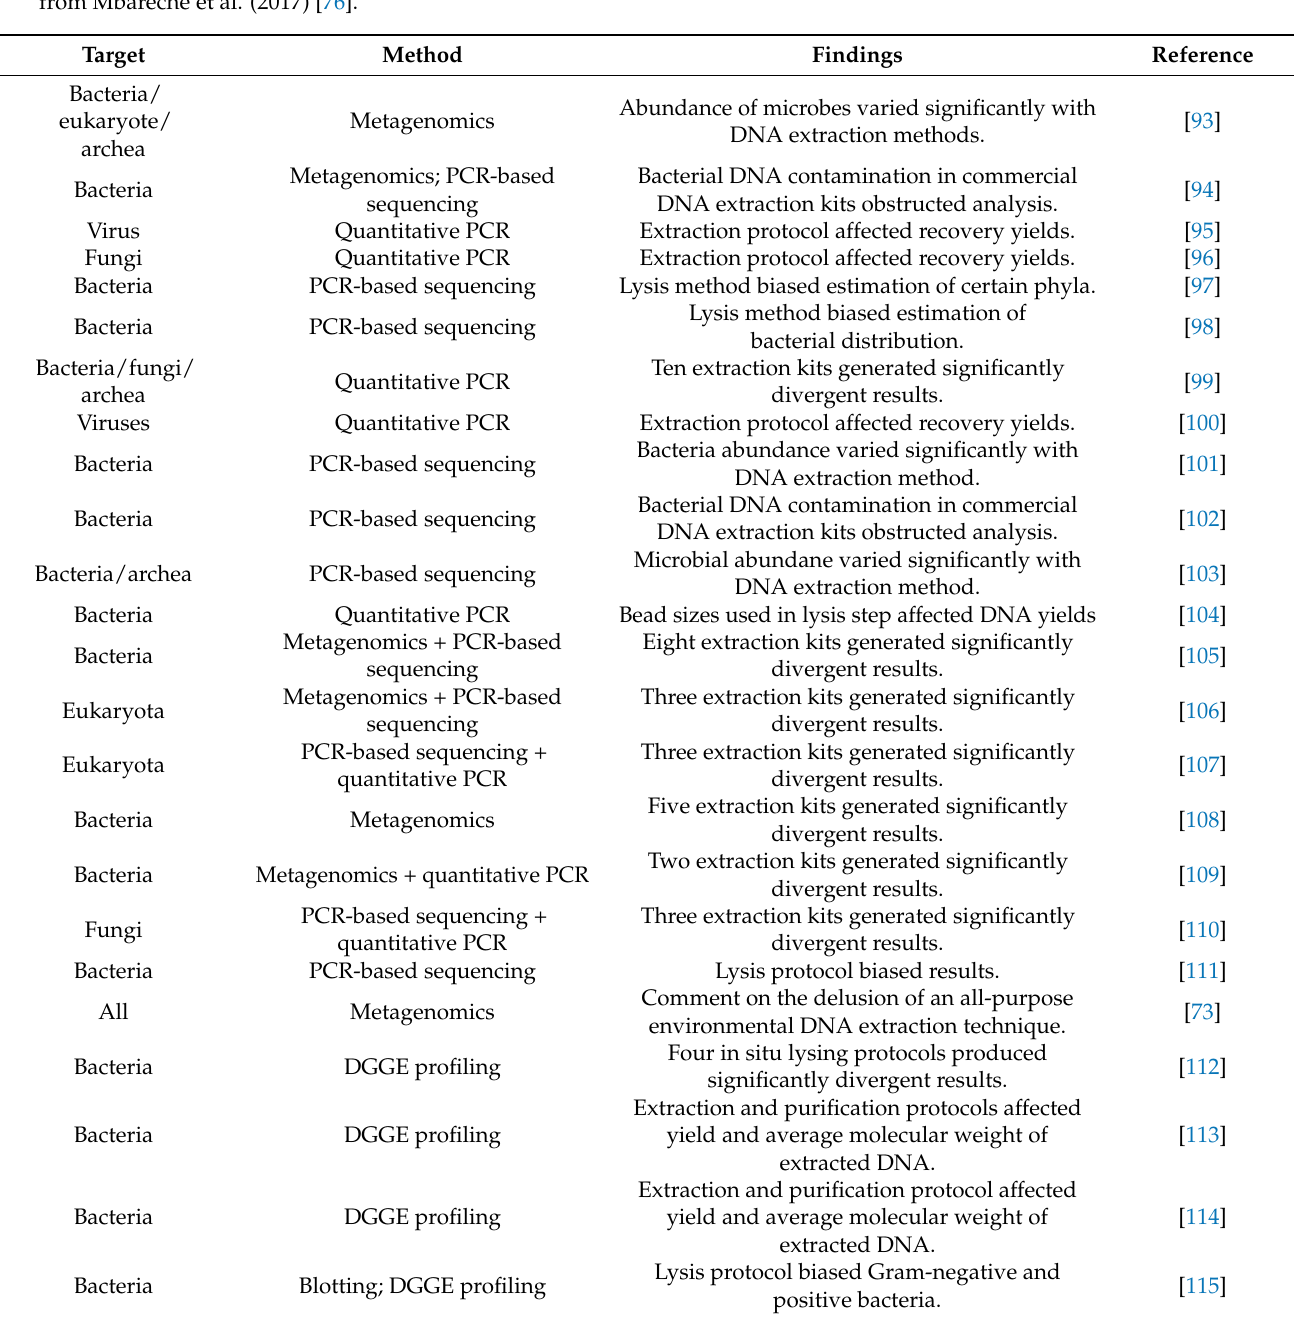
Table 1. Studies documenting biases introduced by various DNA extraction protocols. This table is an extended version from Mbareche et al. (2017)